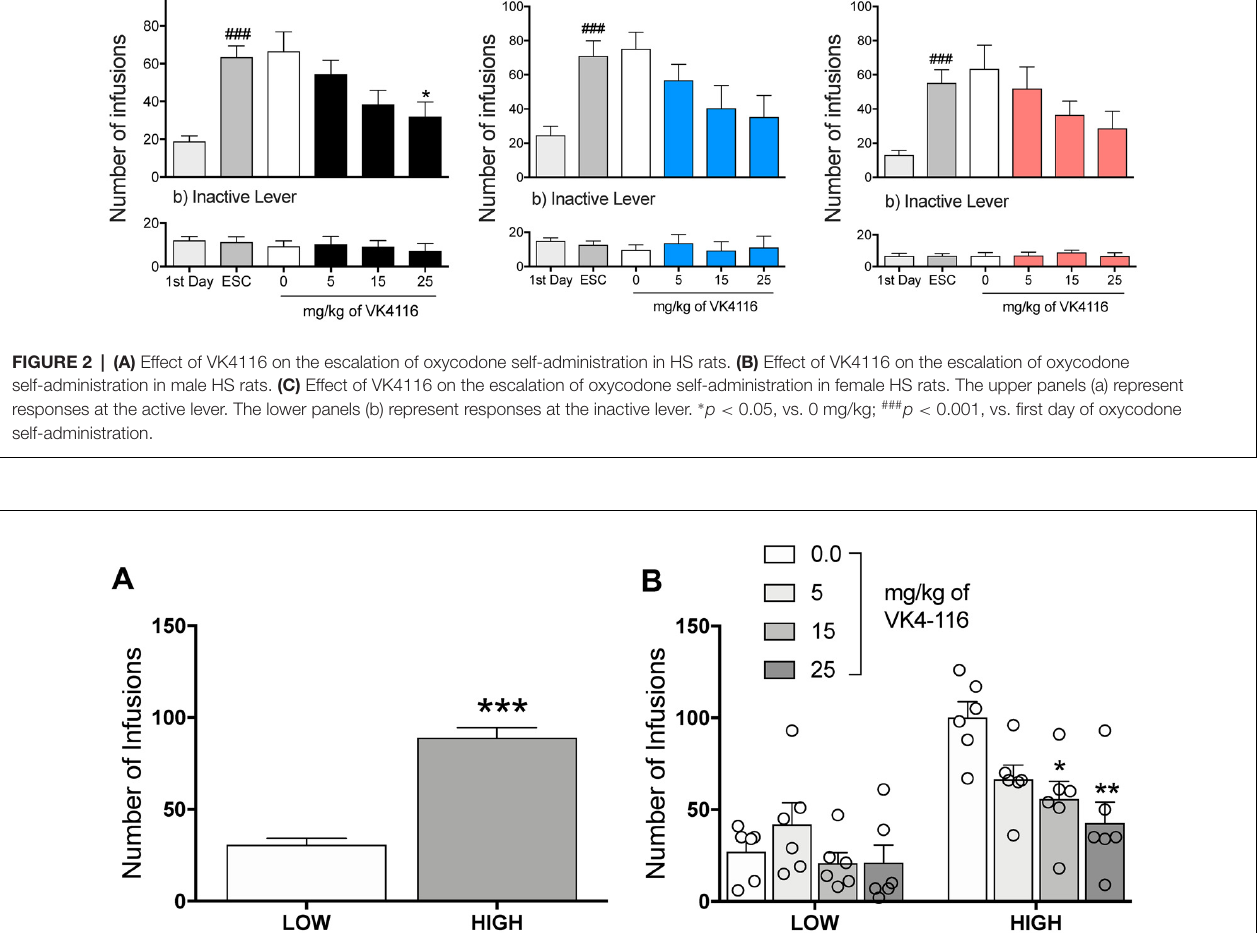
Frontiers in Behavioral Neuroscience |